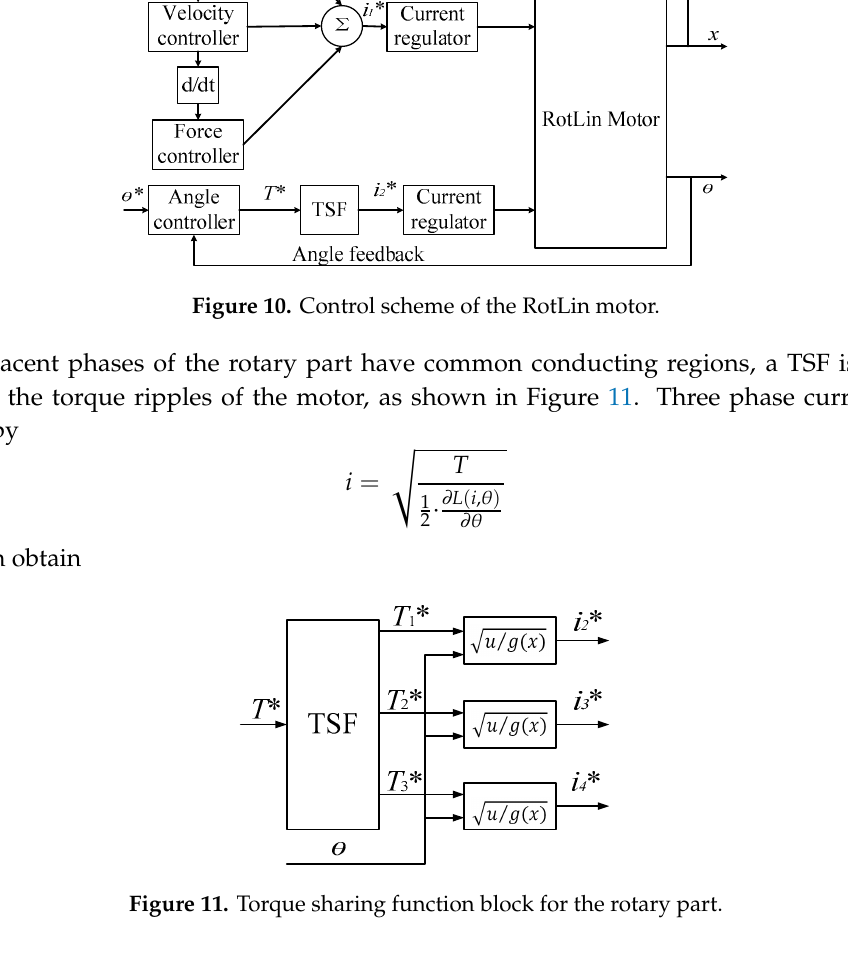
Figure 11. Torque sharing function block for the rotary part.